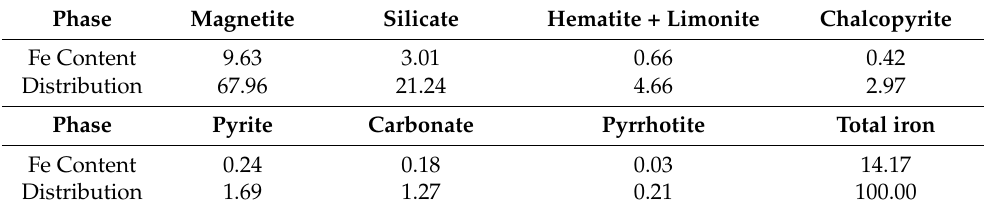
Table 5. Iron chemical phase analysis of the polymetallic ore (%).